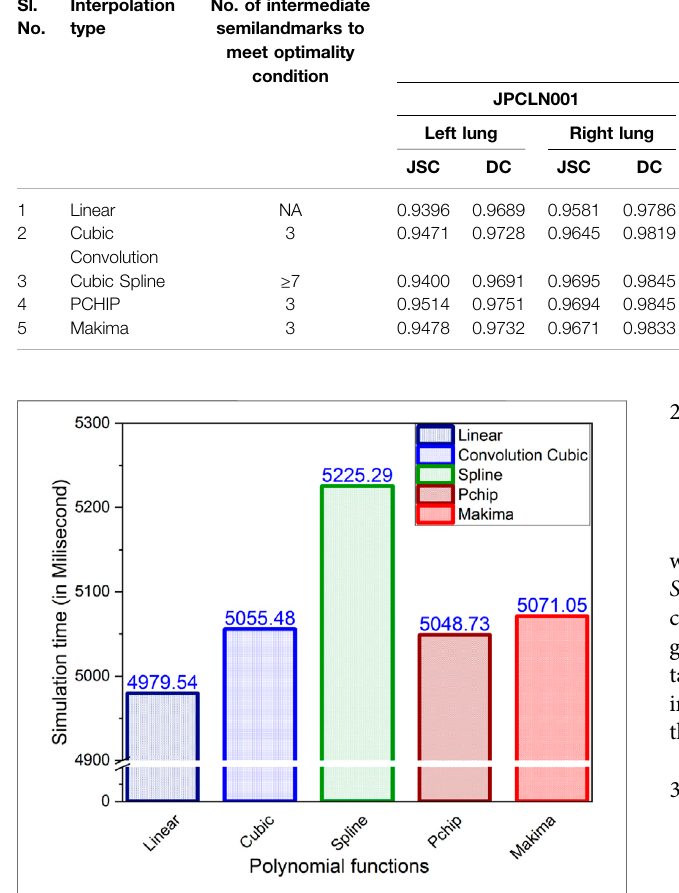
TABLE 1 | Jaccard ’ s and Dice ’ s coef fi cients of different interpolation schemes with their optimality condition. Sl. Interpolation No. type